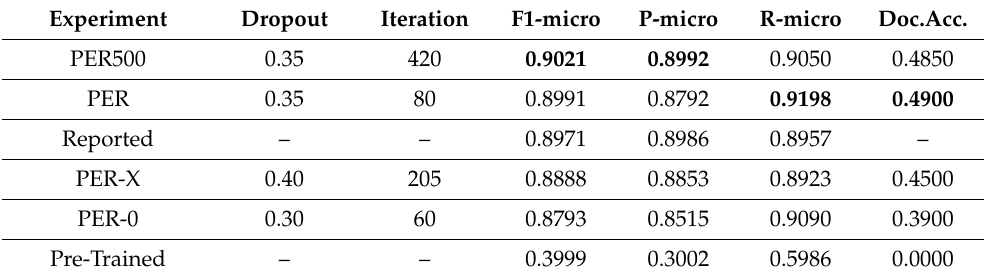
Table 2. Performance of the best classifier (measured by F1-micro) for each type of